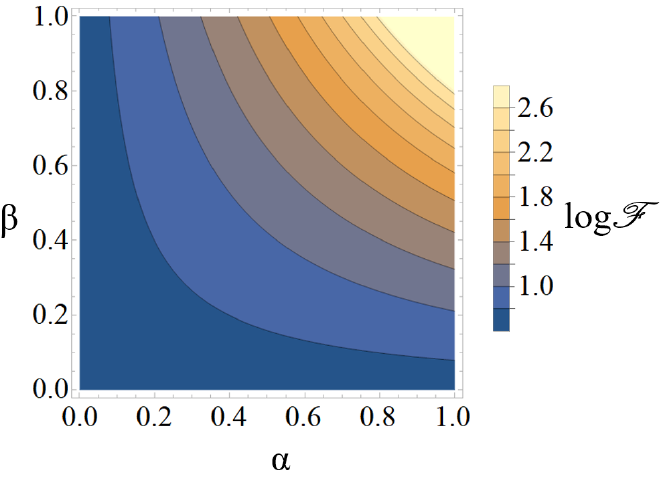
Figure 6. Effect of transmission ( β ) and propagation ( α ) on the quality factor Q , represented by contours of log F (Equations (19) and (25)).